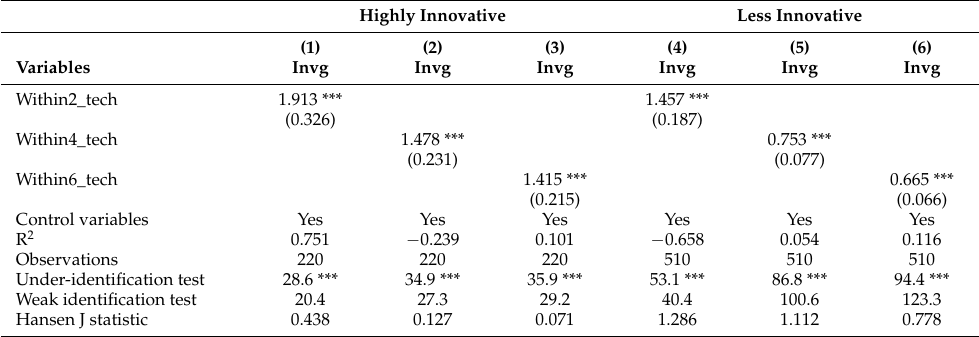
Table 6. The heterogeneous impact of city level on invention patents granted: government scientific funds (top 30% as highly innovative